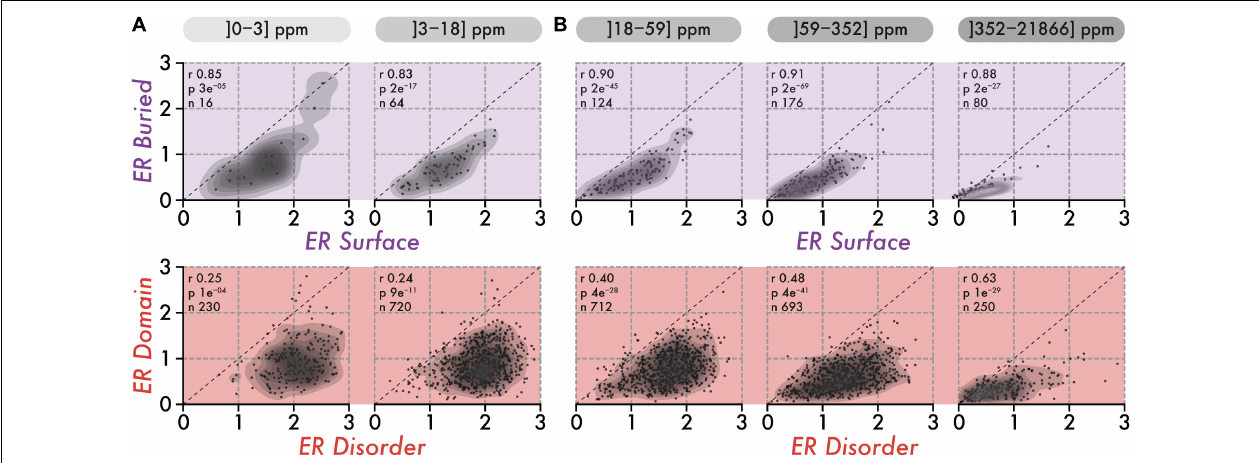
FIGURE 2 | The correlation in the conservation of disorder vs domain regions is poor among low abundance proteins and increases with abundance. (A) The top row shows the average evolutionary rate (ER) of surface residues ( x -axis) vs buried residues ( y -axis) per protein, for two classes of abundance (0–3 and 3–18 ppm or parts per millions). The lower row shows the average ER of disordered residues ( x -axis) vs residues in domains ( y -axis) per protein, for the same two classes of abundance. A protein falling on the diagonal (dashed line) means that residues in the two regions being compared have equal evolutionary rates (i.e., a ratio of 1). The